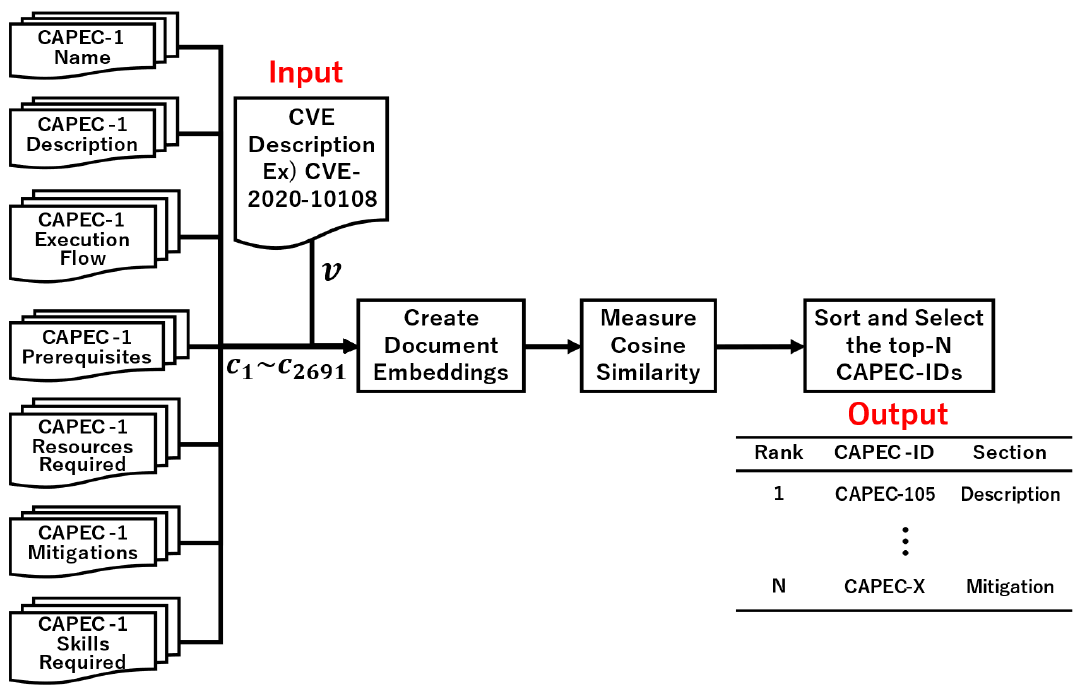
Figure 2. Overview of the proposed approach using all sections.